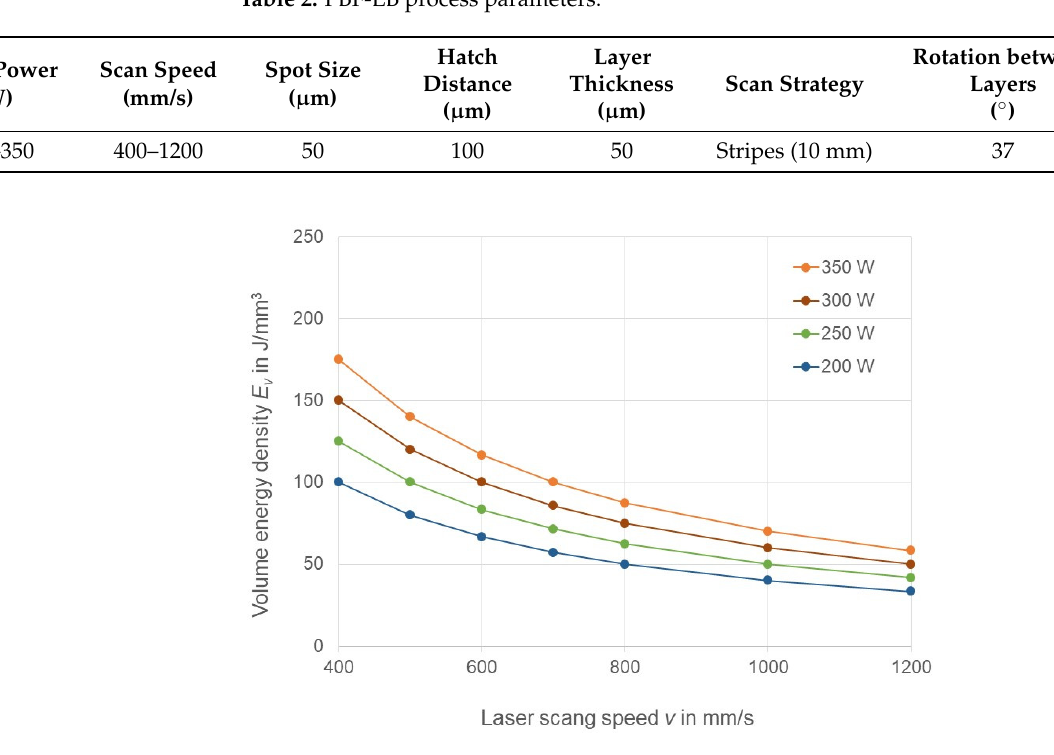
Figure 1. Laser energy density in the function of laser power and laser scan speed.